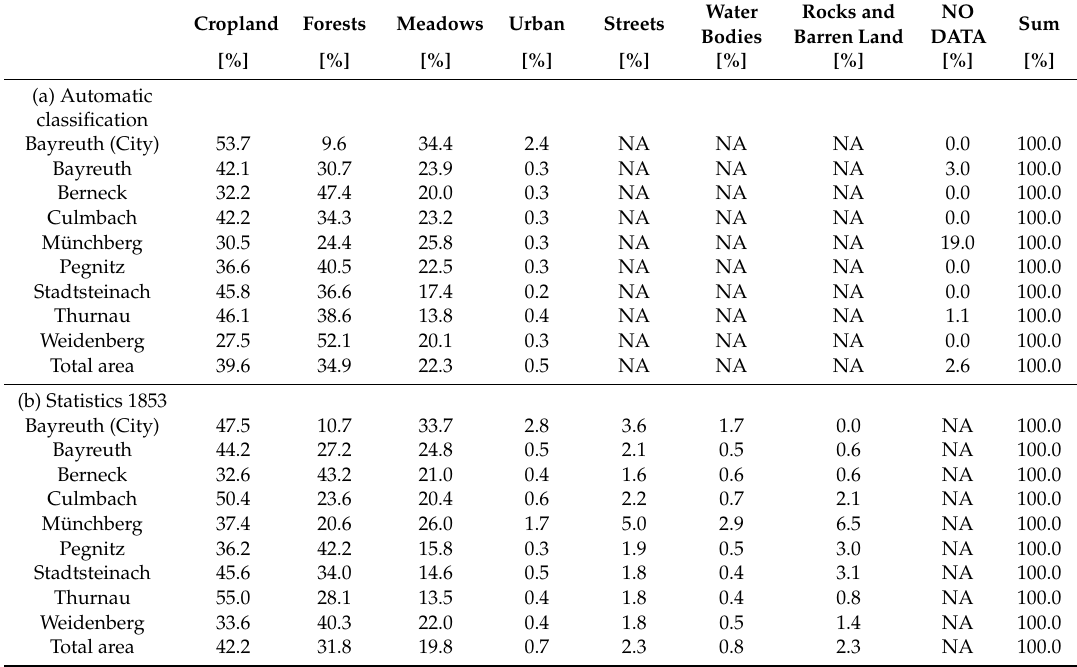
Water Rocks and NO Bodies Barren Land